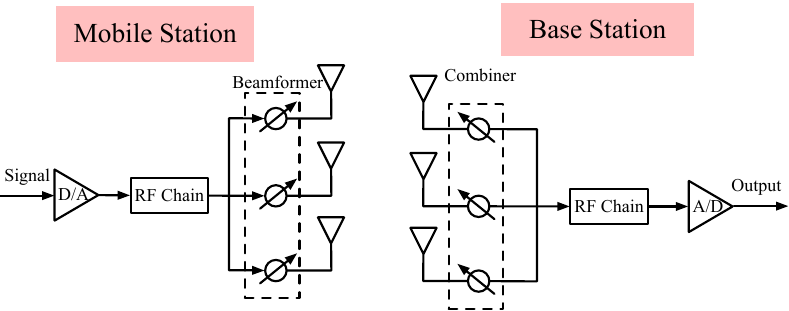
Figure 1. The system model with analog transmit beamforming and receive combining